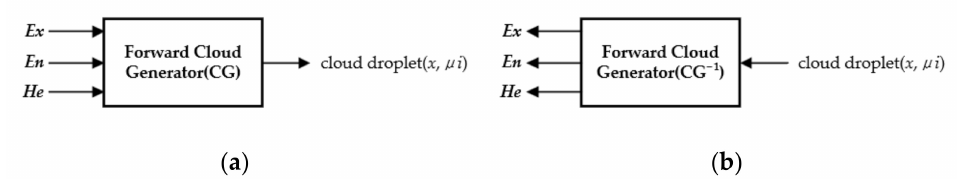
Figure 1. The process of the cloud generator: ( a ) the forward cloud generator; ( b ) the backward cloud